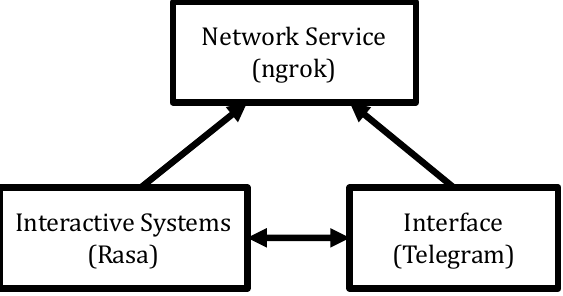
Figure 3. Linking dialogue systems and